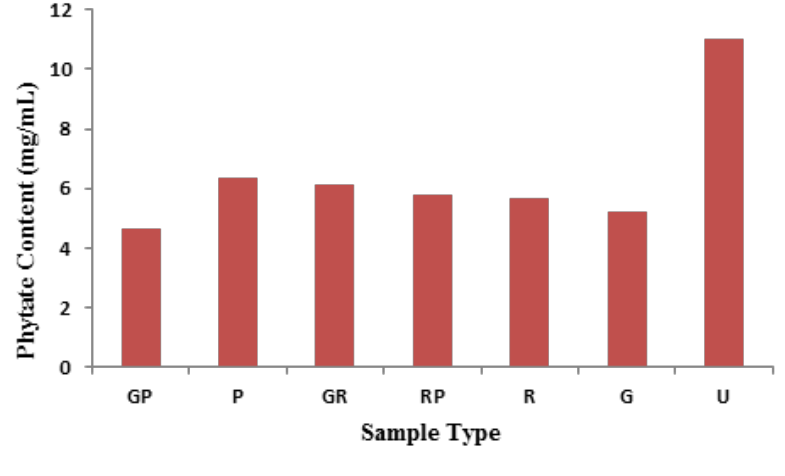
Figure 4: Phytate content of yoghurt from pre-treated Bambara groundnut. Keys: GP= Germinated parboiled P= Parboiled GR= Germinated roasted R= Roasted RP= Roasted parboiled G= Germinated U=